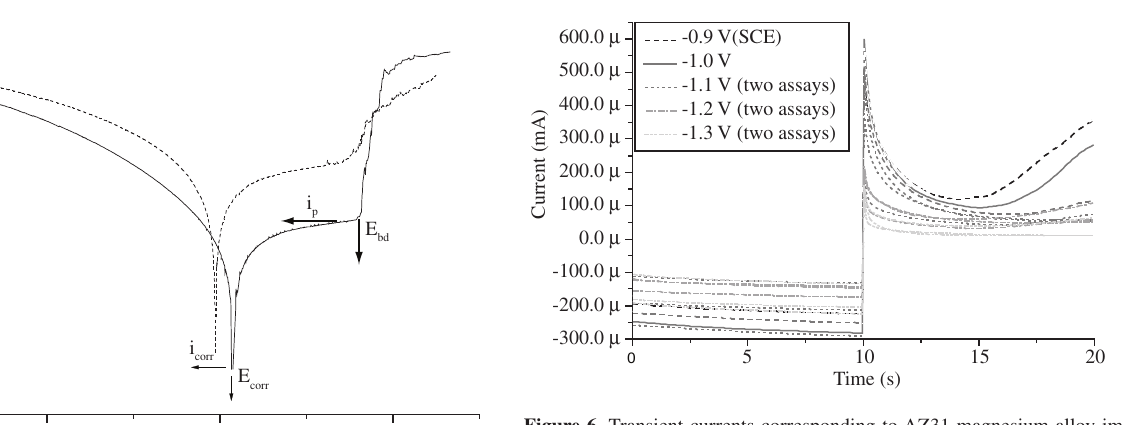
Figure 6. Transient currents corresponding to AZ31 magnesium alloy im- mersed in 1 g/L NaCl. Different records at -1.8 V are shown (left) followed by a potential step to a potential E in the -1.3 V to -0.9 V potential range (right). At potentials ≥ -1.2 V a current increase is observed.